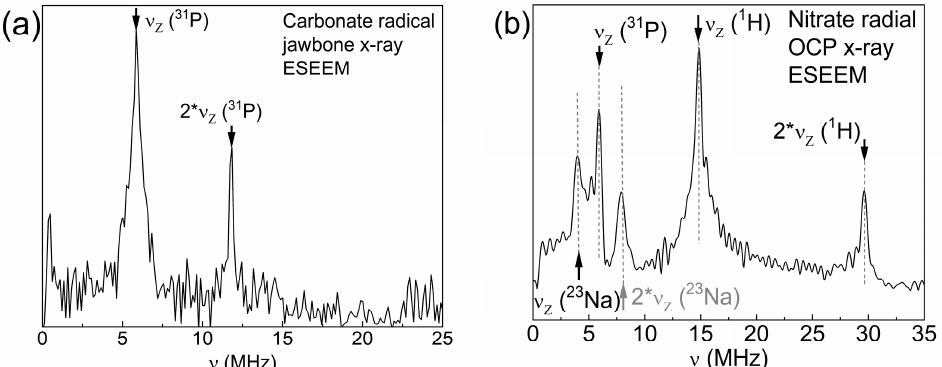
Figure 5. ESEEM spectra of irradiated jawbone containing HA ( a ) and OCP ( b ) samples registered in a perpendicular orientation (B 0 ) of carbonate and nitrate radicals, respectively (see Figure 1a).